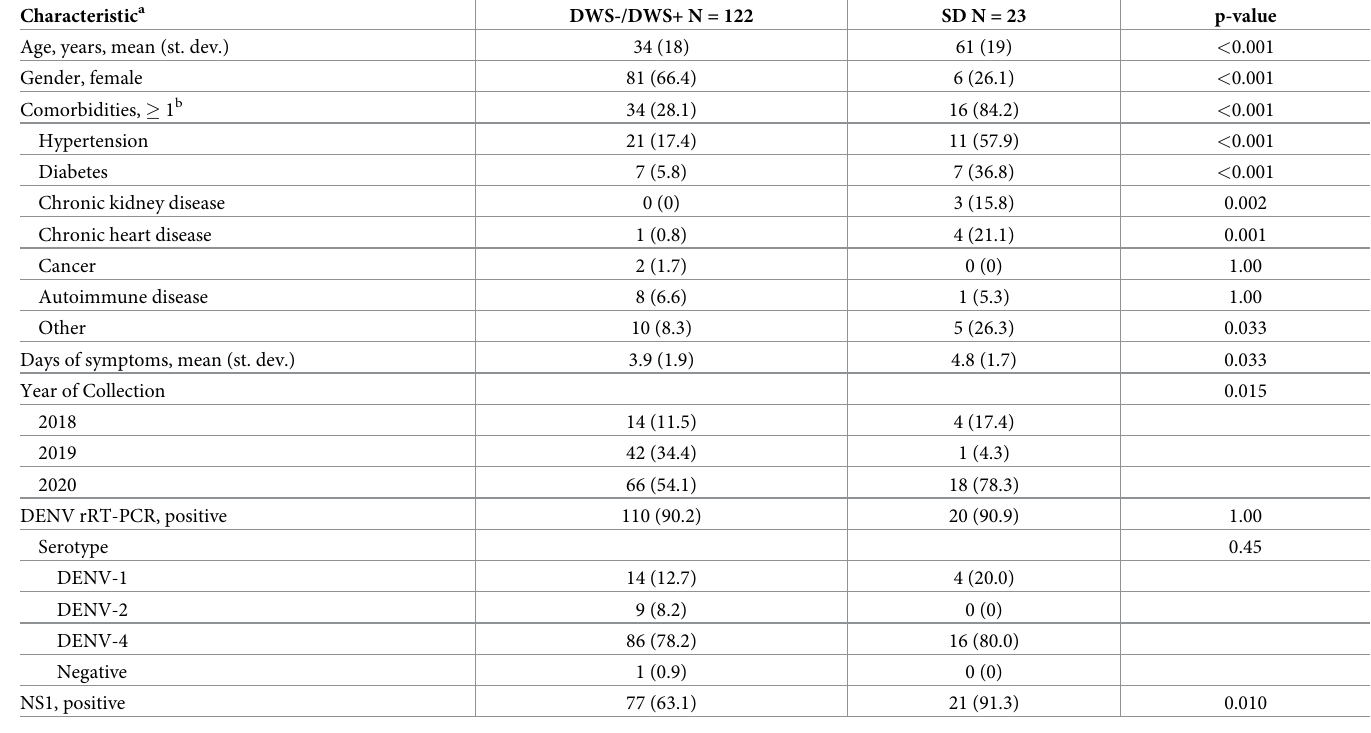
Table 1. Demographic data and DENV diagnostic test results for participants stratified by dengue severity.